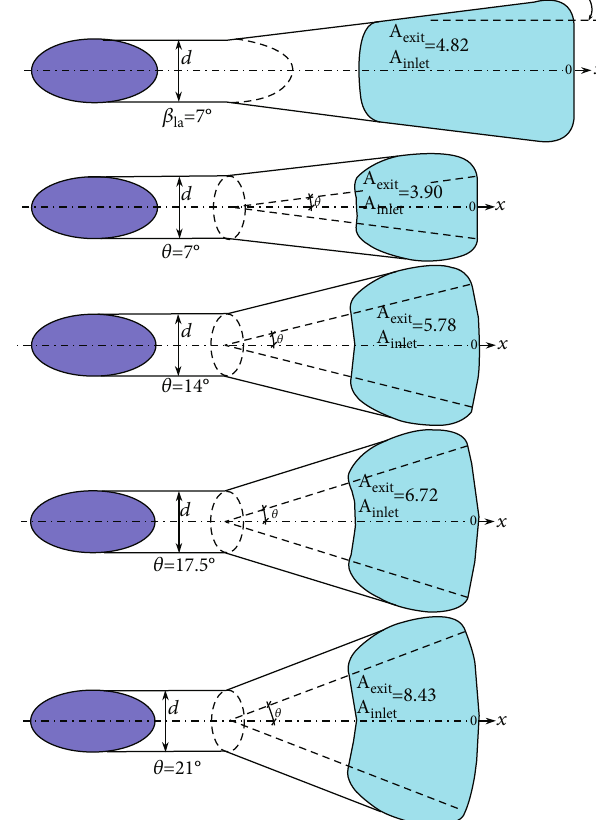
Figure 3: Film holes top views.